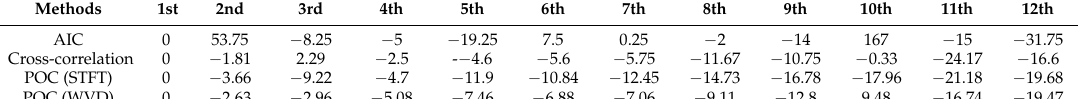
Table 8. The estimated values of the relative arrival times of the third noisy dataset (SNR = − 2 dB). Methods